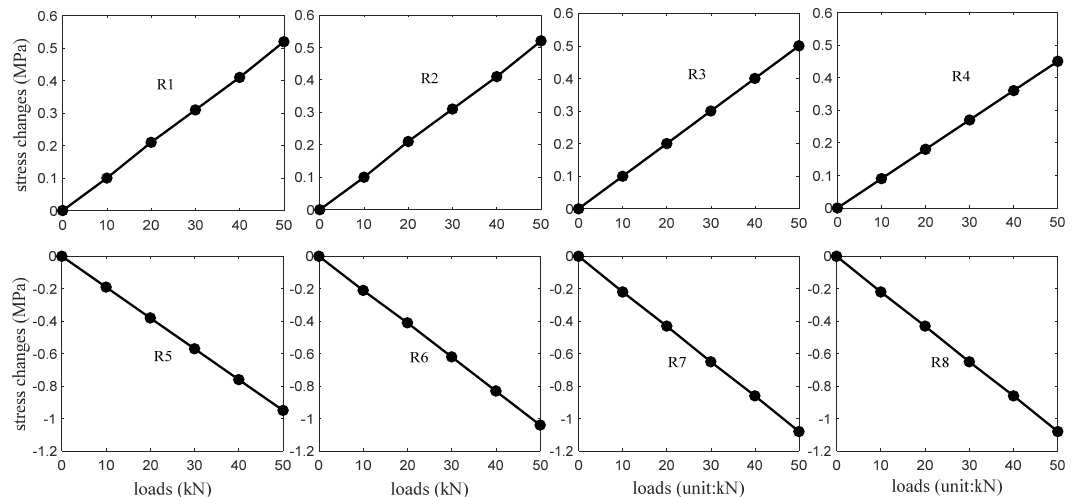
Figure 8. The structural analysis results of the stress changes at the R1 ∼ R8 positions.